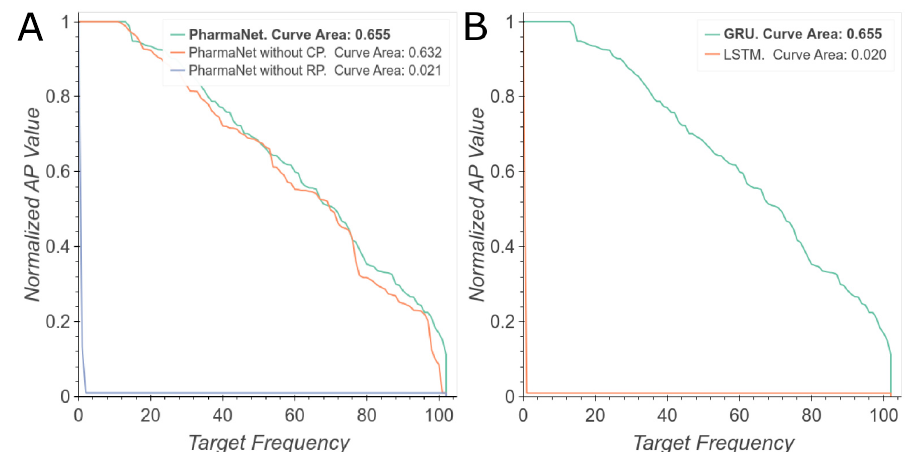
Fig 4. Main ablation experiments. (A) NAP curves evaluating the three main phases of our architecture. (B) NAP curves evaluating different RNNs. Best viewed in color.